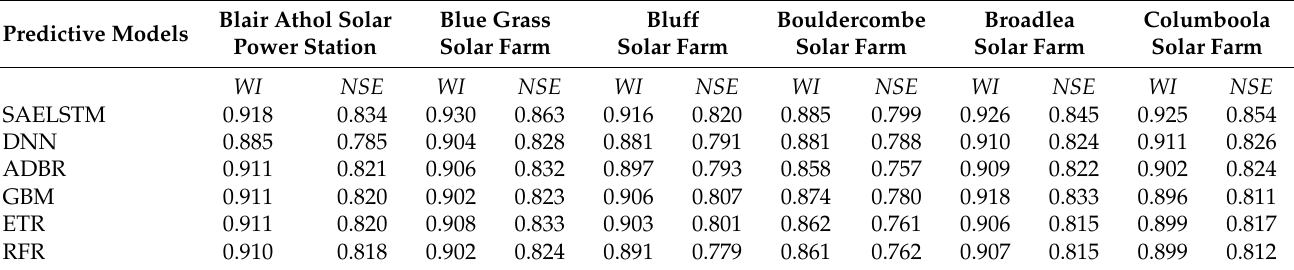
Table 5. As per Table 5 but measured in terms of the Willmott’s Index ( WI ) and Nash–Sutcliffe coefficients (NSE).